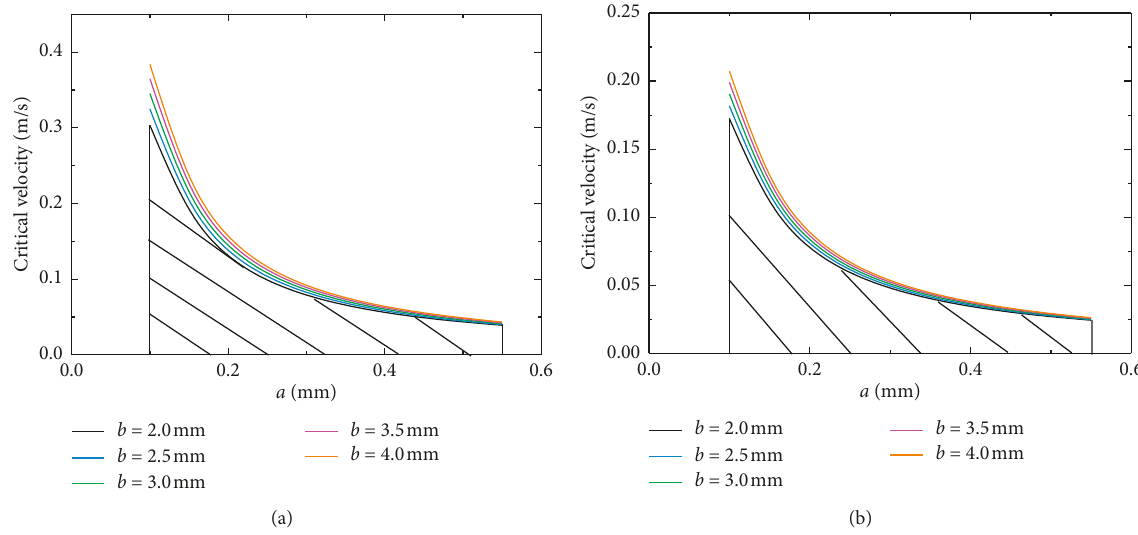
Figure 14: Relationship between particle size and critical velocity in laminar flow under three-particle arrangement and five-particle arrangement. (a) Three-particle arrangement. (b) Five-particle arrangement.